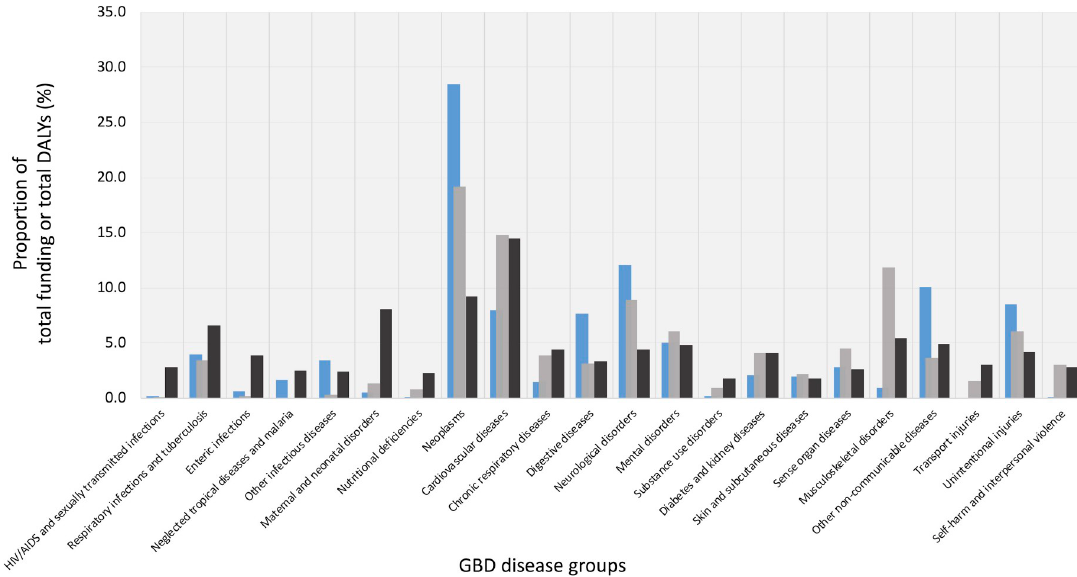
Fig 2. Balance of total health R&D funding and Japan’s and global DALYs. Gray: Japan’s DALYs; Black: Global DALYs; Blue: disease- specific R&D funding for 2015 and 2016. Proportion does not include ‘unclassifiable’. Unintentional injuries do not include transport